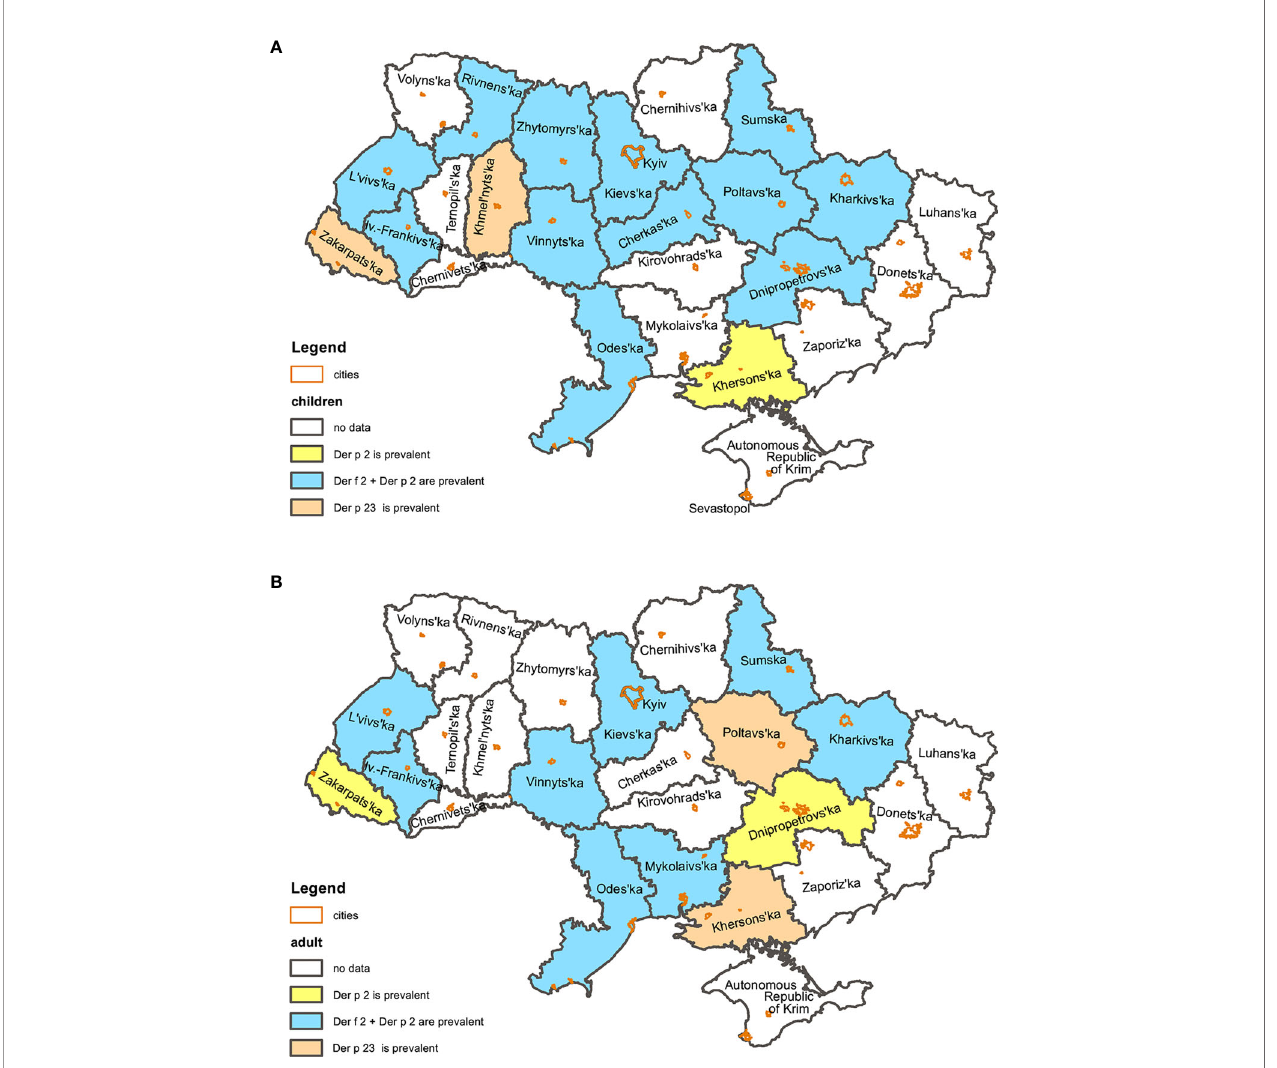
FIGURE 3 | Regional patterns of children (A) and adult (B) sensitization to HDMs in